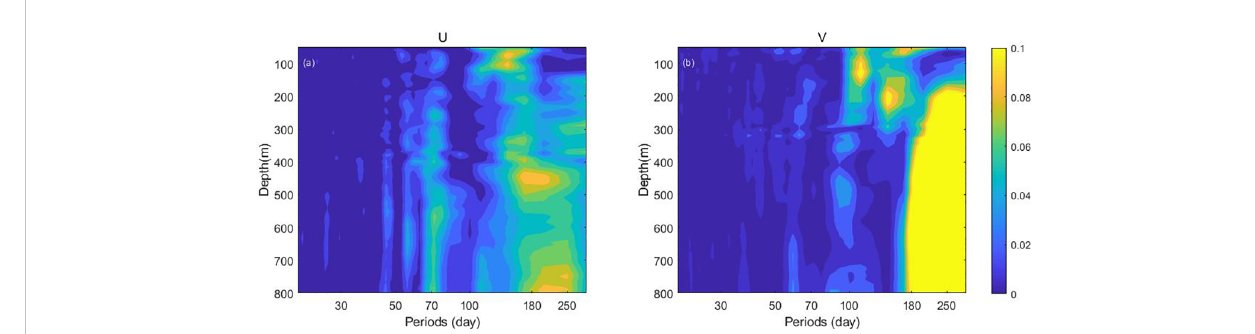
FIGURE 6 Power Spectral Density of velocity measured by ADCPs in (A) zonal and (B) meridional currents.